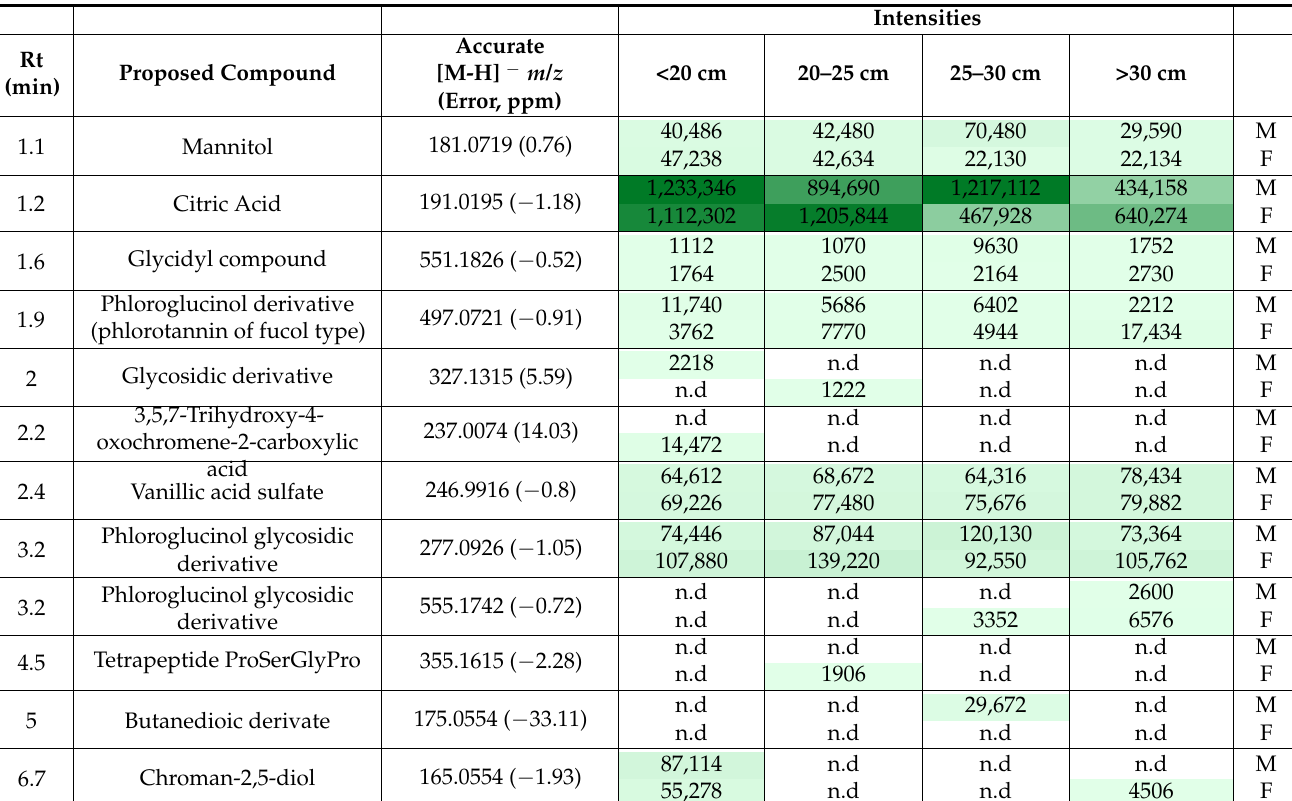
Table 1. Tentative identification of several compounds present in aqueous extracts at 100 °C of F. vesiculosus and corresponding heatmap representing their intensity throughout growth stages and genders. M.: Male; F.: Female. Intensity: 1,200,000 ; 1000 . n.d: not detected.